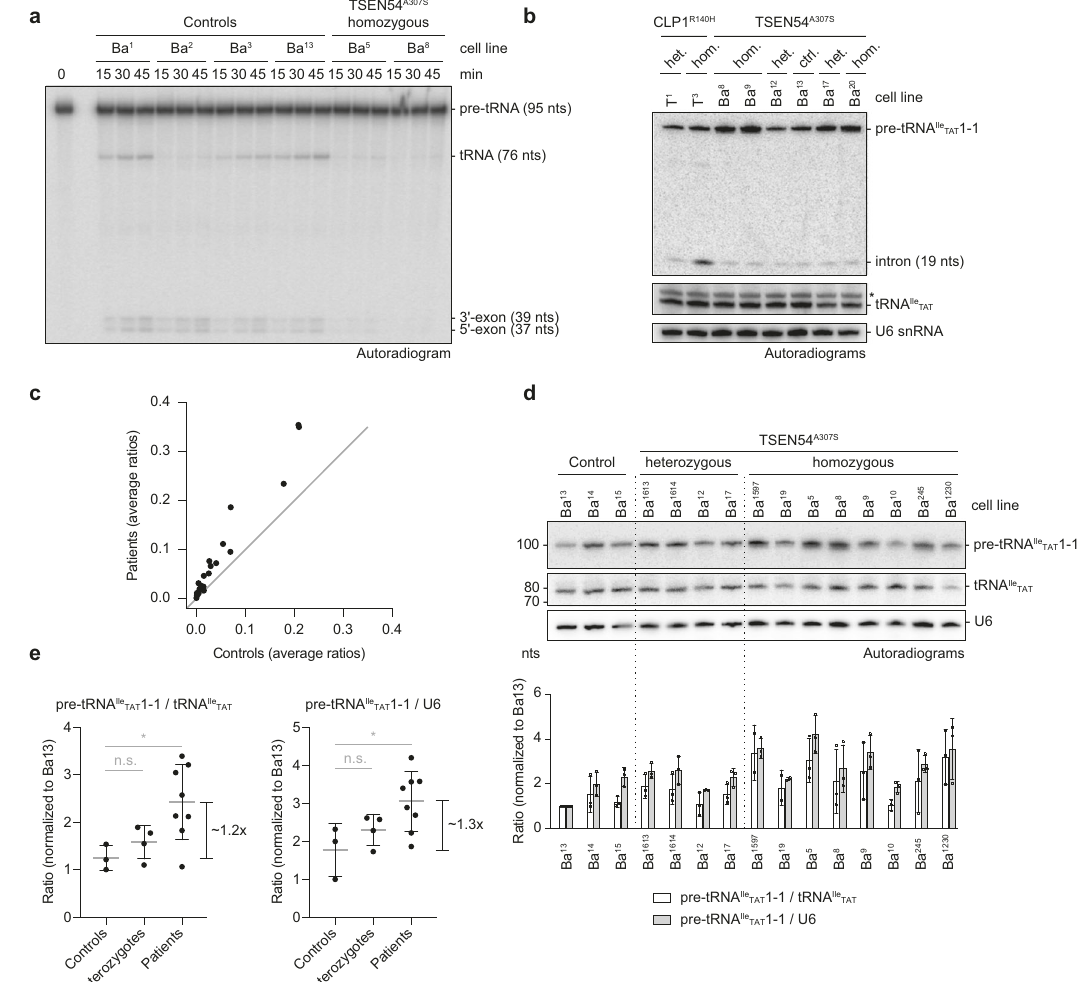
Fig. 5 TSEN54 c.919 G >T fi broblasts exhibit reduced splicing activity in vitro and accumulation of intron-containing pre-tRNAs. a Pre-tRNA splicing assay (time course) with radioactively labeled S.c . pre-tRNA Phe GAA and cell extracts derived from control and PCH patient fi broblasts. Splicing products were separated by urea-PAGE and monitored by phosphorimaging. b Comparison of pre-tRNA Ile TAT 1-1 intron abundance between control cells and fi broblasts carrying the heterozygous or homozygous TSEN54 c.919 G >T (TSEN54 A307S ) or the CLP1 c.419 G > A (CLP1 R140H ) mutation by northern blotting. c Average ratios of pre-tRNAs to mature tRNAs derived from Hydro-tRNAseq for all intron-containing tRNAs comparing PCH patients to wild-type control samples. The black line indicates a slope of 1. d Northern blot analysis comparing pre-tRNA Ile TAT 1-1 levels to levels of mature tRNA Ile TAT or U6 snRNA in control fi broblasts and fi broblasts carrying the heterozygous (het.) or homozygous (hom.) TSEN54 c.919 G > T mutation. The data are representative of three independent experiments. Signal intensities were quanti fi ed and displayed as ratios normalized to Ba 13 in the bottom panel. Data are presented as mean values ± SD. e Statistical representation of northern blot analysis in d. Mean ratios of signal intensities for pre-tRNA Ile TAT 1-1 to tRNA Ile TAT (left panel) or to U6 snRNA (right panel) were normalized to Ba 13 , and grouped into control, heterozygous, and homozygous patient classes ( n = 3, different control fi broblast cell lines; n = 4, different heterozygous fi broblast cell lines; n = 8, different homozygous PCH patient fi broblast cell lines carrying the TSEN54 c.919 G > T mutation). Unpaired Student´s t -test (two-tailed) for ratios of pre-tRNA Ile TAT 1-1 to mature tRNA Ile TAT or to U6 snRNA revealed a signi fi cant difference between control and patient cell lines of 1.2-fold (* P = 0.0371) or 1.3-fold (* P = 0.0344), respectively. Data are presented as mean values ± SD. Panels in a and b are representative of at least two independent experiments. Source data for a , b , c , and e , are provided as Source Data fi